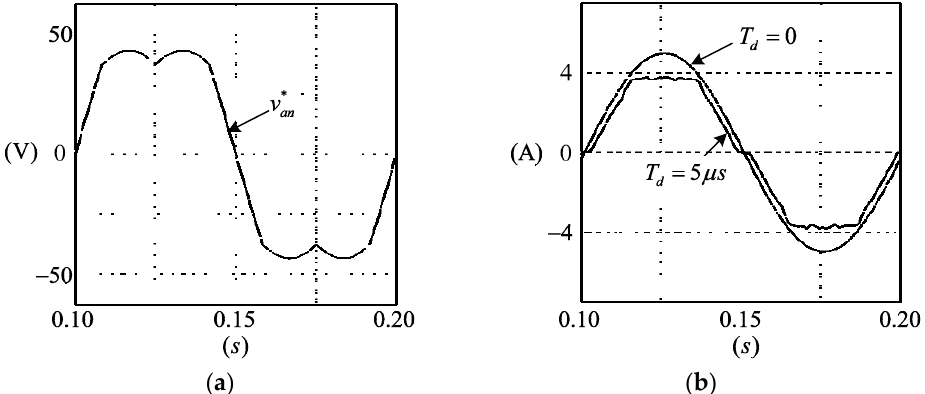
f = 20 kHz, V = 100 V, L = 0.01 mH, R = 10 sw dc s s